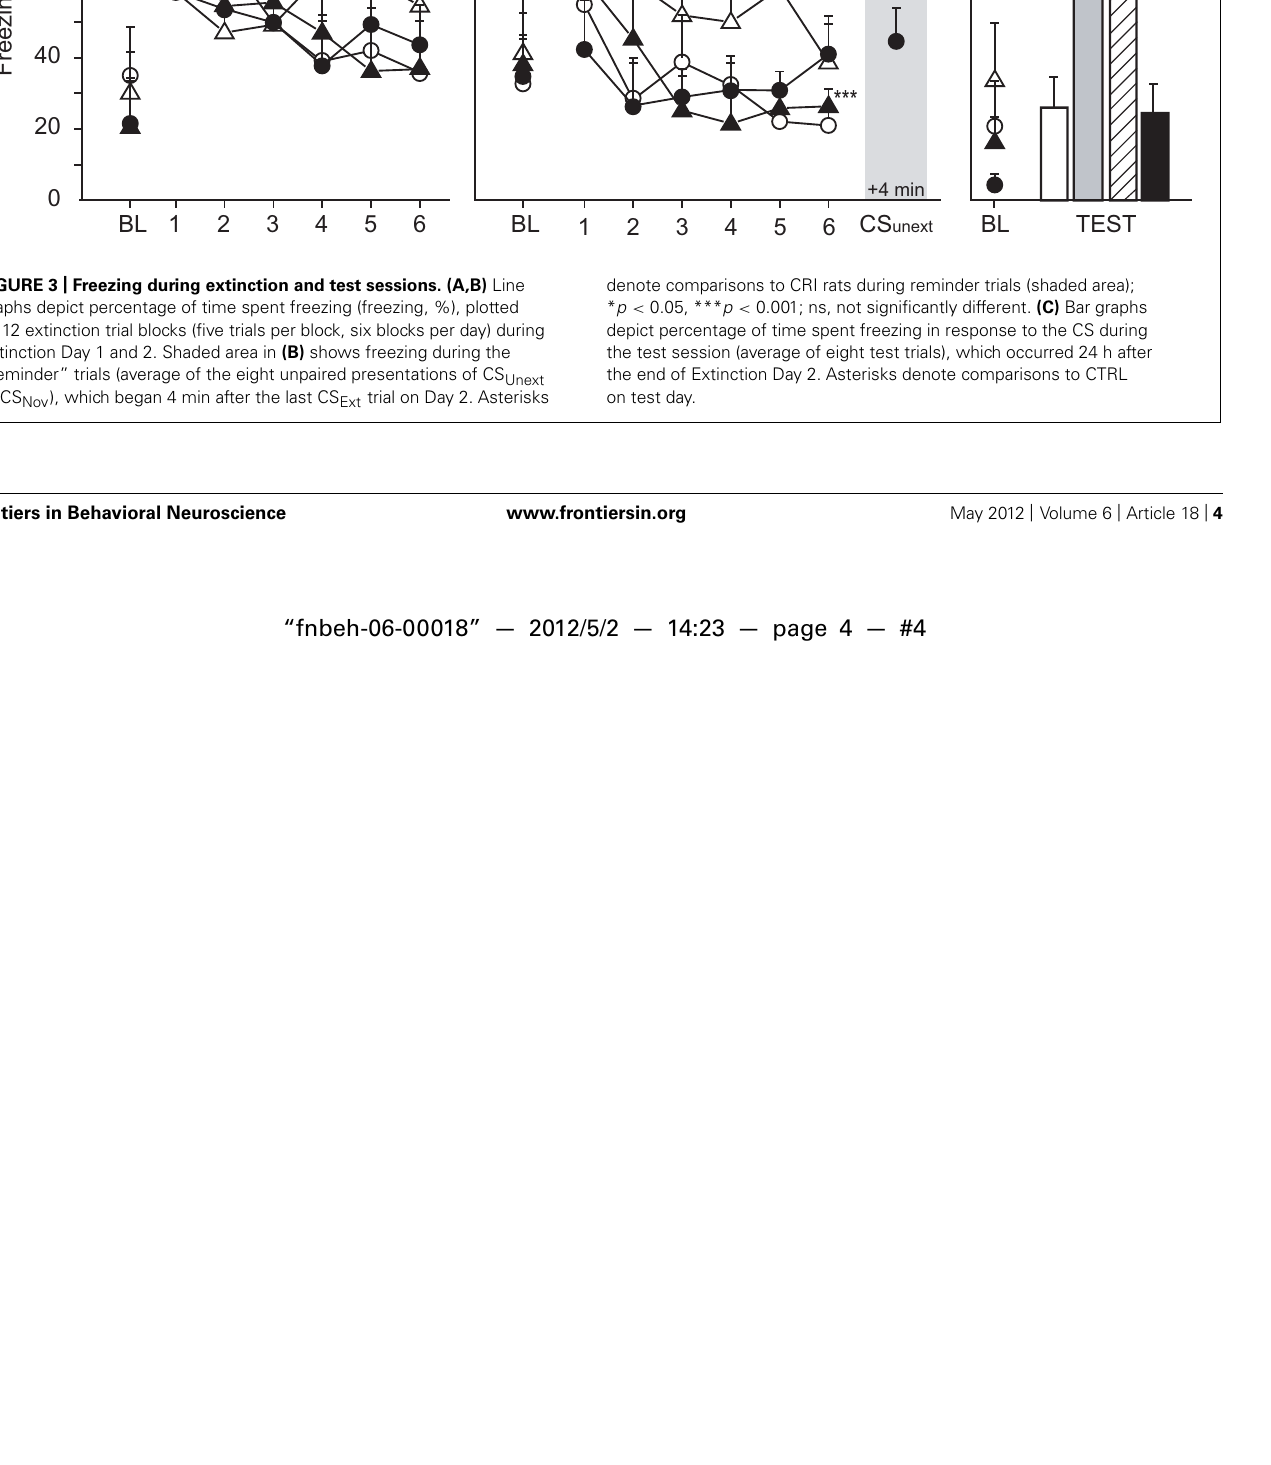
denote comparisons to CRI rats during reminder trials (shaded area); * p < 0.05, *** p < 0.001; ns, not significantly different. (C) Bar graphs depict percentage of time spent freezing in response to the CS during the test session (average of eight test trials), which occurred 24 h after the end of Extinction Day 2. Asterisks denote comparisons to CTRL on test